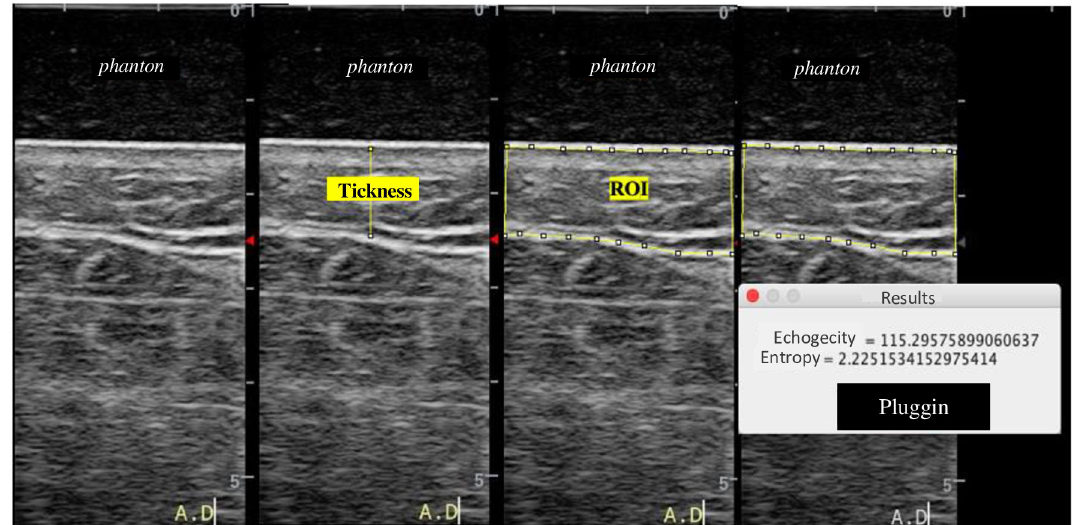
Fig 2. Image of thickness, echogenicity and entropy evaluation in Image J. Source : Personal